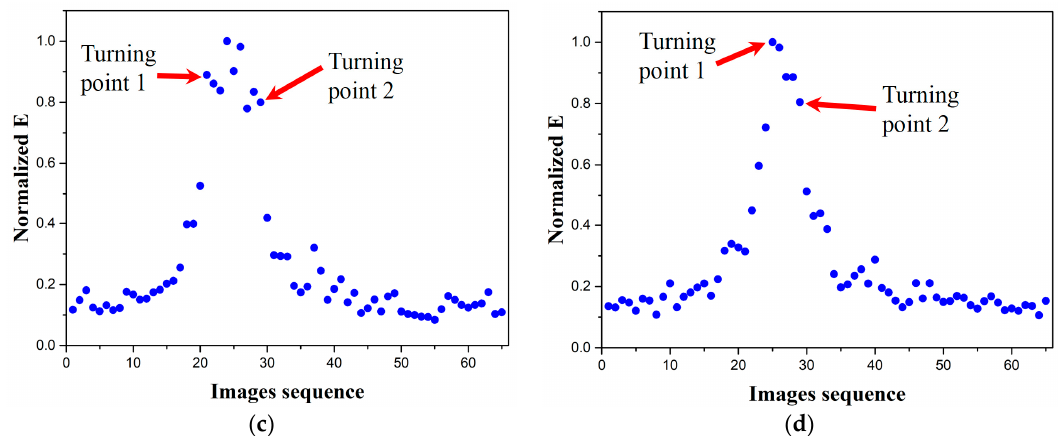
Figure 8. Images of subsurface damage for sample #1. ( a ) Image under bright field illumination; ( b ) Image under total internal reflection illumination; ( c ) Definition curve of the short crack; ( d ) Definition curve of the long crack.